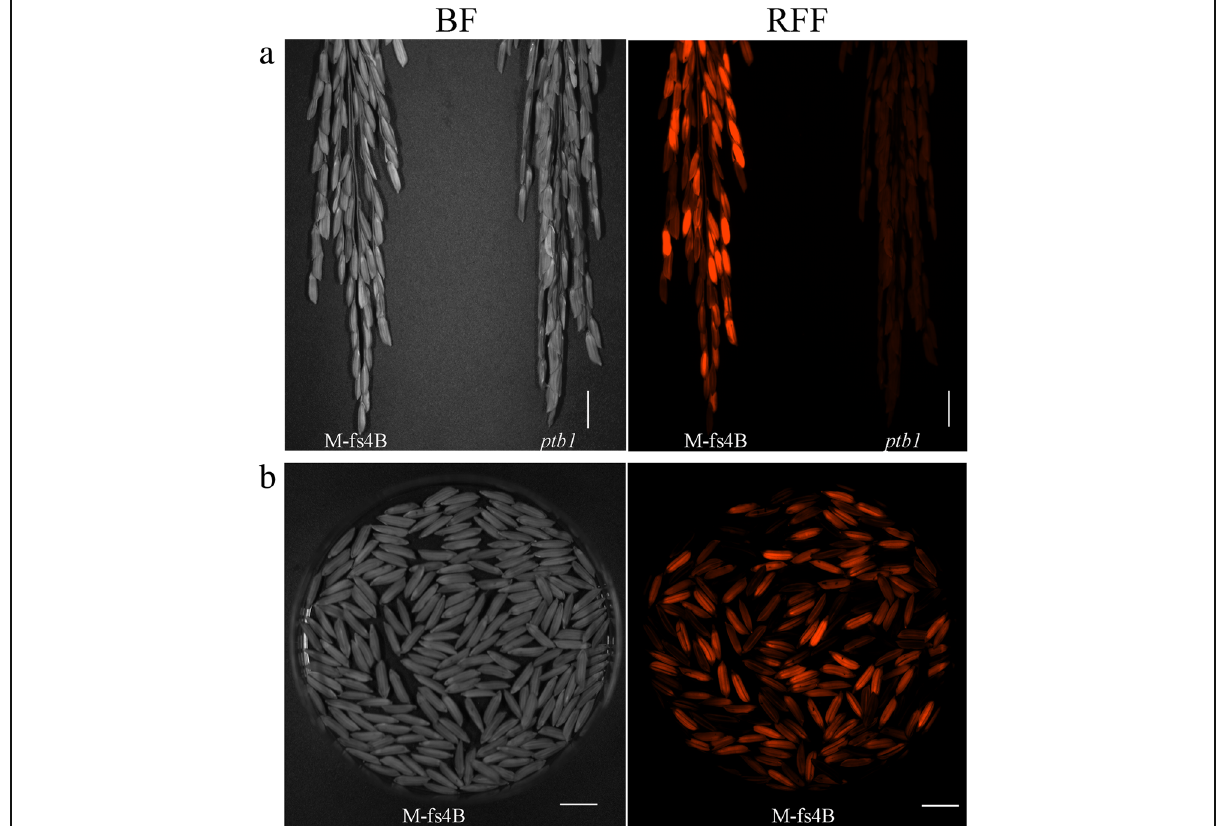
Fig. 6 ( a ) M-fs4B and ptb1 panicles under bright field (BF) and a red fluorescence filter (RFF). (Scale bar, 1.3 cm). ( b ) Seeds of M-fs4B under bright field (BF) and red fluorescence filter (RFF). (Scale bar, 1.0